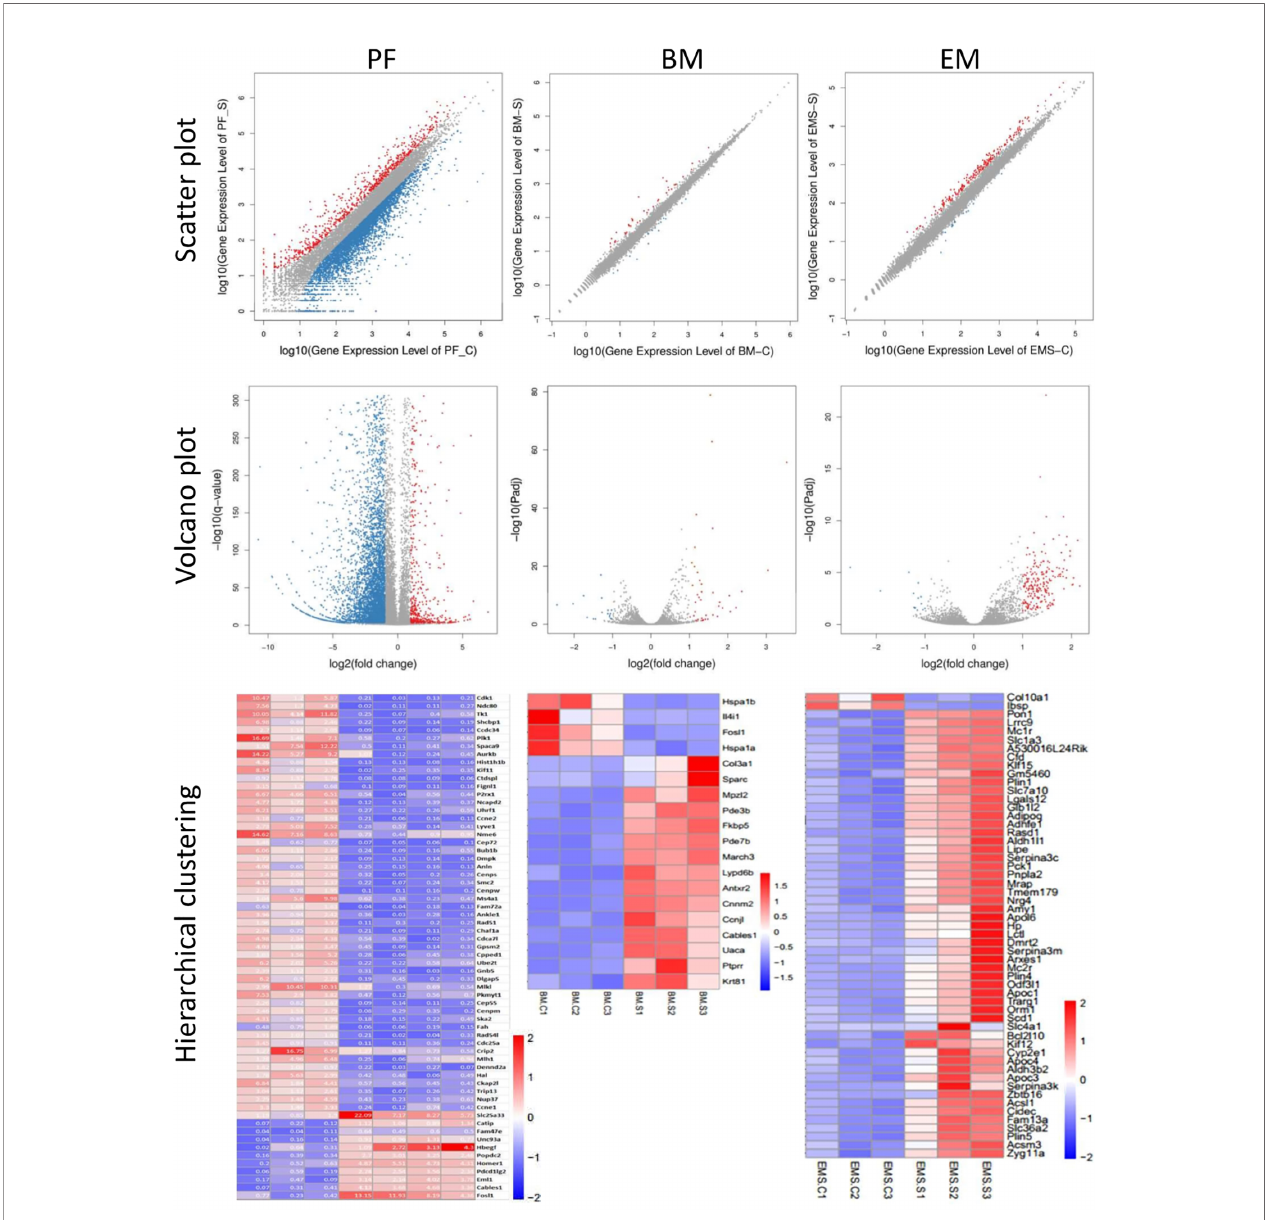
FIGURE 5 | Differential gene expression of G-MDSC cells and endometriotic lesions. (Upper panels) Scatter plots of peritoneal (PF) and bone marrow (BM) CD11b+ Ly6G+ G-MDSCs and endometriosis lesions (EM) from 3-4 animals in each group after 7 days of Sunitinib treatment (S) versus control (C). X Y axis represents log10 transformed gene expression level, red color represents the up-regulated genes, the blue color represents the down-regulated genes, gray color represents the non- DEGs. (Middle panels) Volcano plots of peritoneal (PF) and bone marrow (BM) CD11b+ Ly6G+ G-MDSCs and endometriosis lesions (EM) from 3-4 animals in each group after 7 days of Sunitinib treatment (S) versus control (C). X axis represents log2 transformed fold change. Y axis represents -log10 transformed signi fi cance. Red points represent up-regulated DEGs. Blue points represent down-regulated DEGs. Gray points represent non-DEGs. (Lower panels) Heat map of peritoneal (PF) and bone marrow (BM) CD11b+ Ly6G+ G-MDSCs and endometriosis lesions (EM) from 3-4 animals in each group after 7 days of Sunitinib treatment (S) versus control (C) by hierarchical clustering. X axis represents the sample. Y axis represents the DEGs. The color represents the log 2 transformed gene expression level. The dark color means the high expression level while the light color means the low expression level. The most signi fi cant differentially expressed genes (p < 0.05, padj < 0.05 or q < 0.01, and also fold changes > 1.5-5) are shown. The full list and statistical analysis are available in corresponding Supplementary Tables 1 – 3